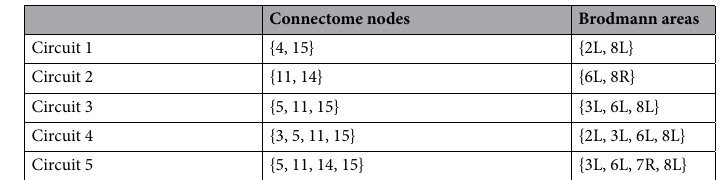
Table 7. Circuits emerging from the Action–Execution evolution with a BN. We hypothesize that these circuits represent the firing over time of all areas involved in the simulated process, with oscillations between